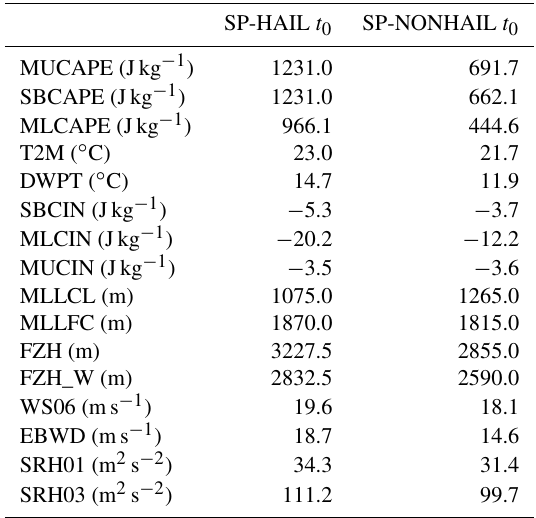
Table 3. Median values for each parameter analyzed for SP-HAIL and SP-NONHAIL events at t c